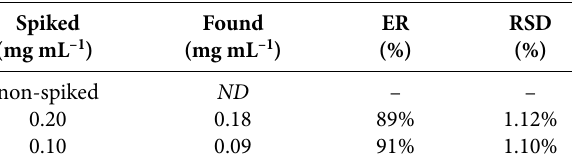
Table 3. Extraction recovery (ER) obtained from the determination of estradiol in real urine samples (n = 3) Spiked Found ER RSD